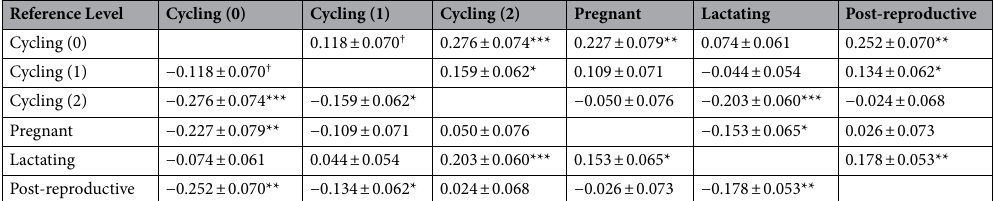
Table 2. Paired comparisons (β ± standard error) of urinary neopterin levels by reproductive status in 36 female chimpanzees. Values were derived from a linear mixed model in which reproductive status was a categorical predictor; the model was run six times so that each reproductive status could serve as the reference level. Cycling females are distinguished by sexual swelling size: 0 = no swelling, 1 = partial swelling, and 2 = full swelling. Please note that urinary neopterin levels were Box–Cox transformed prior to analysis. p-values: *** < 0.001, ** < 0.01, * < 0.05, † <